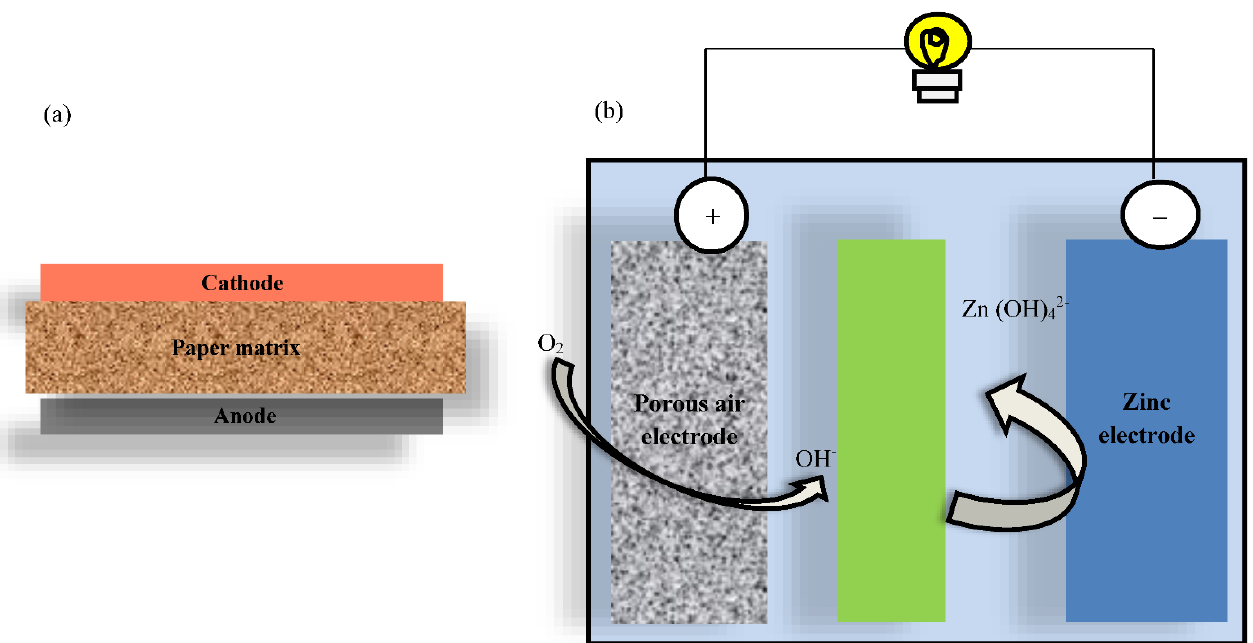
Figure 13. Schematic representation of ( a ) paper-based battery and ( b ) Zinc–air battery.